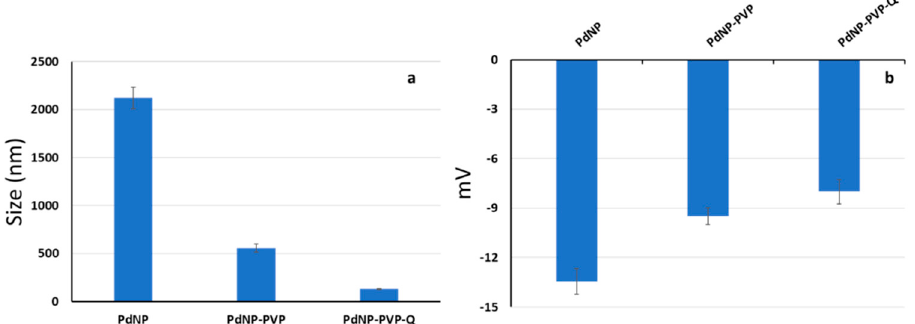
Figure 3. Hydrodynamic size and potential zeta characterization. ( a ). Hydrodynamic size determination. ( b ). Potential zeta size determination. Both were determined in bidistilled water with a concentration of 300 ppm for each nanoparticle.